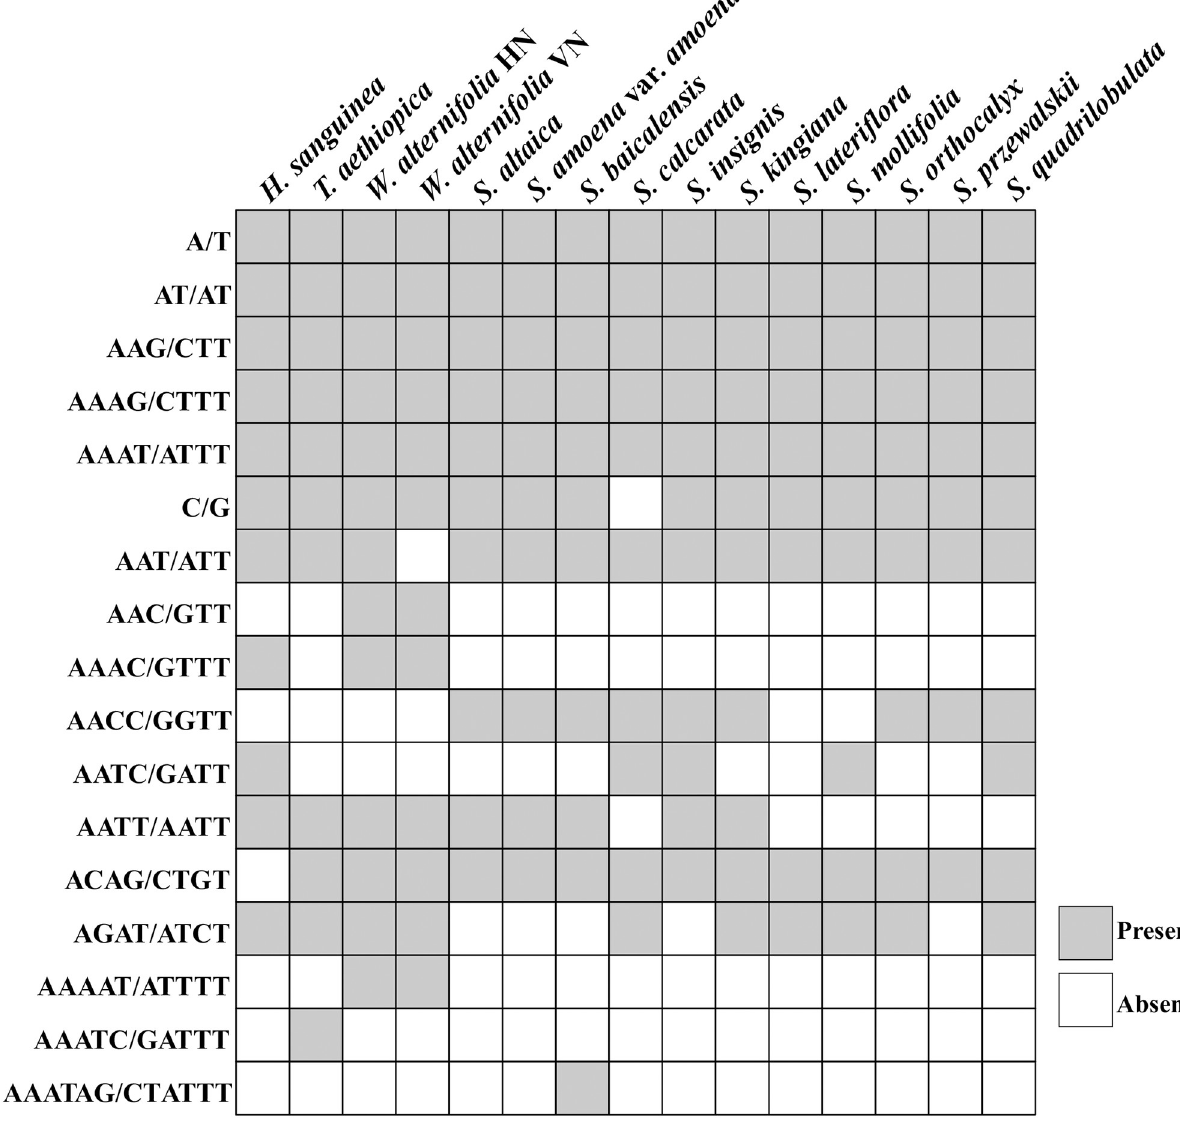
PLOS ONE | https://doi.org/10.1371/journal.pone.0232602 May 7,